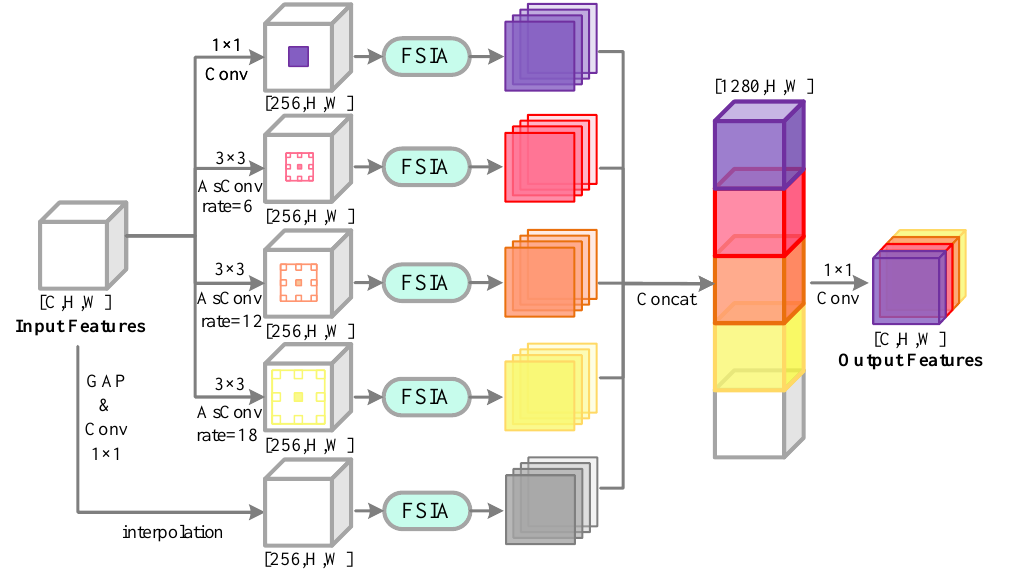
Figure 3. The procedure of